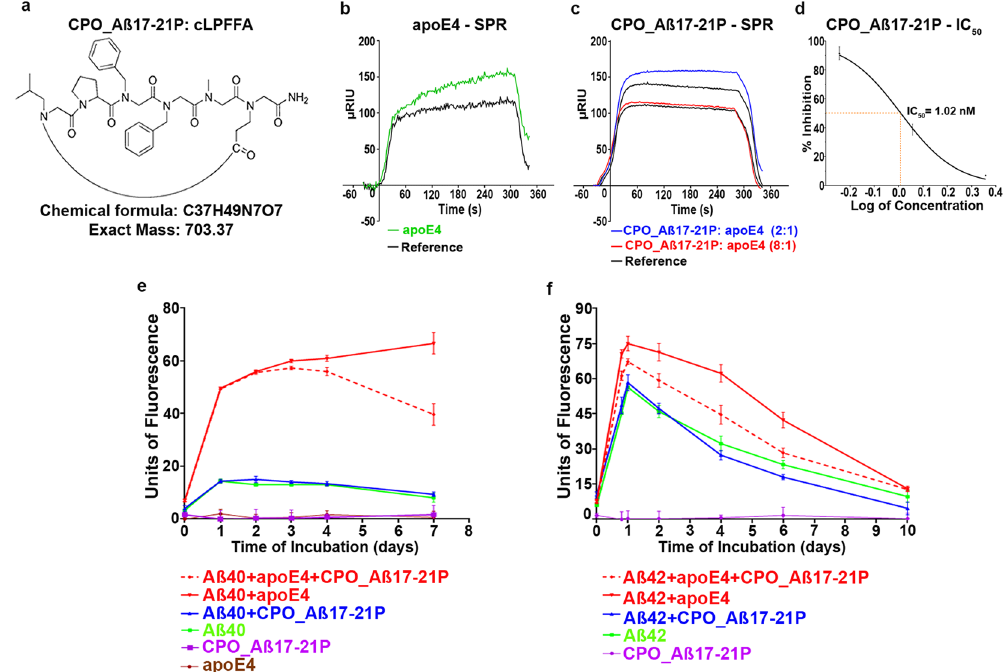
Figure 1. Molecular structure of peptoid CPO_A β 17-21 P and its inhibitory effect on apoE4/A β 42 binding and reduction of apoE4 mediated A β 40 and A β 42 fibrillization. ( a ) Molecular structure of the peptoid CPO_A β 17-21 P. ( b ) Surface Plasmon Resonance assay of apoE4/A β 42 binding. Binding of lipidated apoE4 is shown by the green line with the black line representing the reference. ( c ) Surface Plasmon Resonance assay of CPO_A β 17-21 P inhibition of apoE4/A β 42 binding at a 2:1 (blue line, peptoid:apoE4) and 8:1 molar ratio (red line, peptoid:apoE4), with the black line below each colored line representing the corresponding reference. ( d ) Shown is the half-maximal inhibition (IC50) of lipidated apoE/A β binding by increasing concentrations of CPO_A β 17-21 P derived from a one-site competition, nonlinear, regression equation of CPO_ A β 17-21 P was 1.02 nM, calculated using GraphPad Prism 7.0 (Graphpad, San Diego, CA). ( e ) and ( f ) Thioflavin T A β aggregation assay, showing inhibition of apoE4 potentiated A β 40 and A β 42 fibril formation when incubated with CPO_A β 17-21 P. Solid red line shows the A β 40 (400 µ M, in e) or A β 42 (100 µ M, in f) fibril formation increment when incubated with recombinant apoE4 at 100:1 molar ratio. Dashed red line shows reduction of fibril formation on A β 40 (in ( e ) and A β 42 (in f ) when apoE4 was pre-incubated with peptoid CPO_A β 17-21 P. Green line shows A β 40 (in e ) and A β 42 (in f ) alone, blue line indicates A β 40 or A β 42 incubated with peptoid, brown line indicates apoE4 alone and purple line shows peptoid CPO_A β 17-21 P. Repeated measures analysis of variance followed by a Tukey post-hoc multiple comparison analysis showed p < 0.0001 for difference between group; A β 40 + apoE4 + CPO_A β 17-21 P versus A β 40 + apoE4 p = 0.0034; A β 42 + apoE4 + CPO_A β 17-21 P versus A β 42 + apoE4 p = 0.0011; no significant difference between A β 40 + CPO_A β 17-21 P and A β 40 alone; no significant difference between A β 42 + CPO_A β 17-21 P and A β 42 alone were